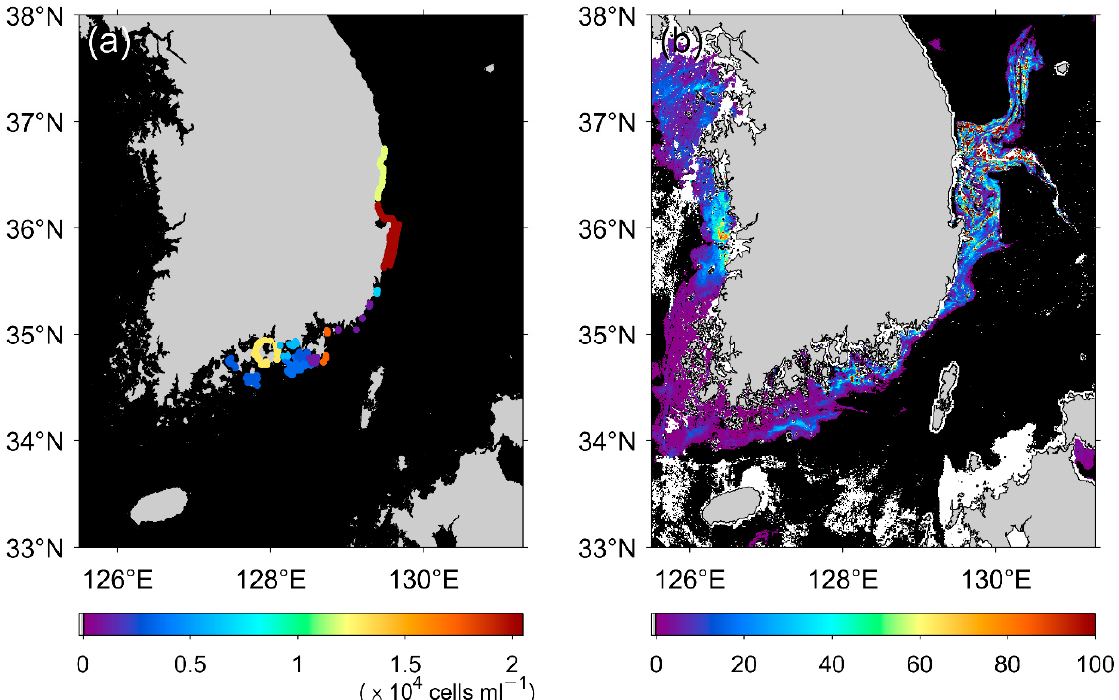
Figure 9. ( a ) Digitized red tide report map with highest density (cells mL − 1 ) and ( b ) NRTI map on 13 August 2013.